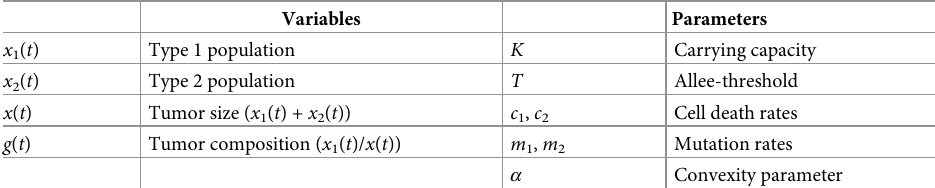
Table 2. The ingredients of our